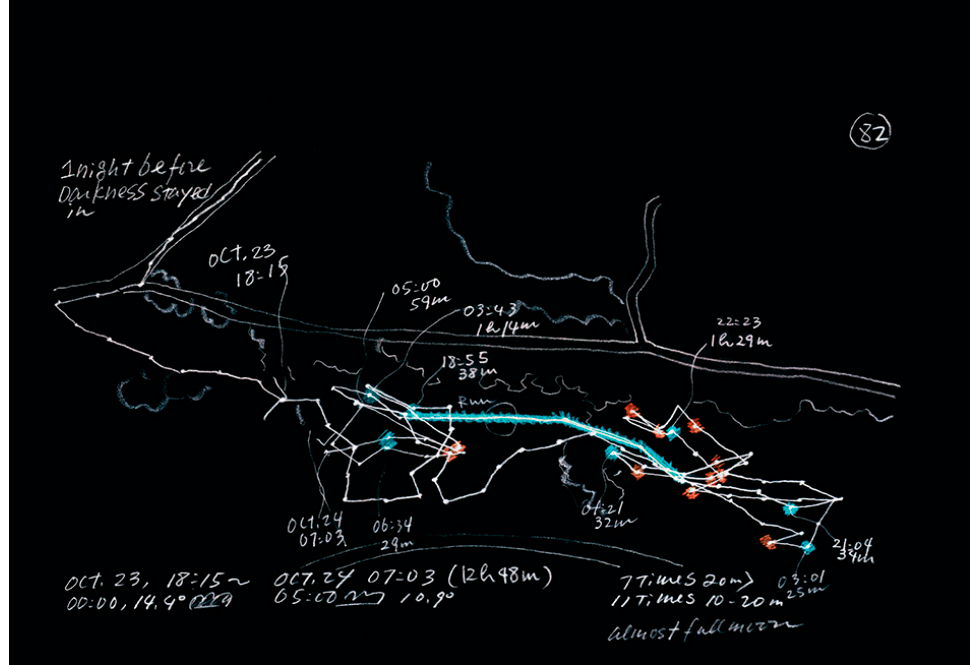
Figure 2. ‘How he moves in the darkness’ (detail), print 5 ″ × 8 ″ each (Collins & Goto Studio 2019).